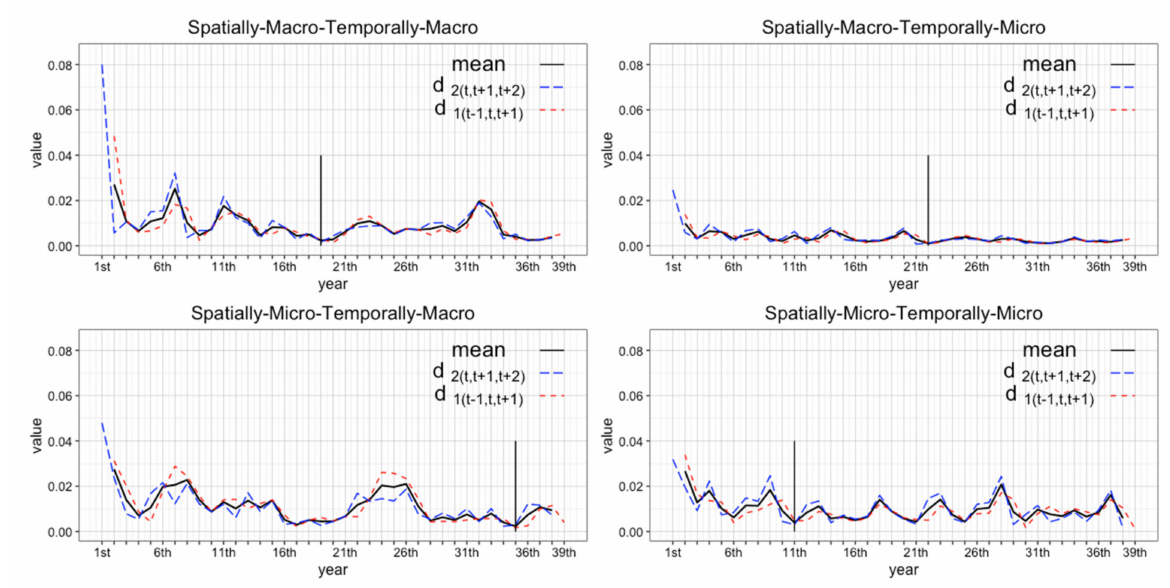
Figure 12. Changes of d 1 ( p , t ) and d 2 ( p , t ) over simulation year.